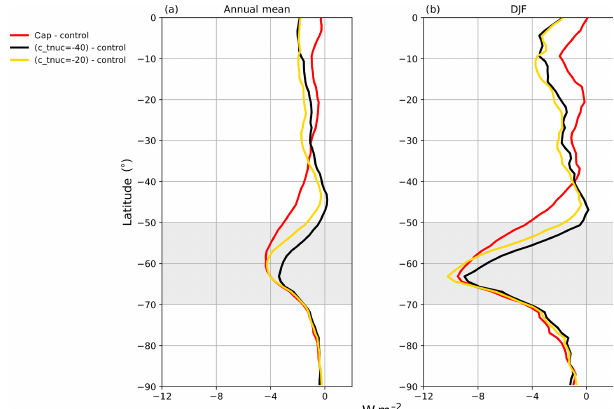
Figure 5. Distribution of zonally averaged SW CRE anomalies over the SH in various experiments with respect to the control model for (a) annual mean and (b) DJF mean. The colour codes are as follows: red indicates cap minus control, black indicates ( c_tnuc=-40 ) minus control; and yellow indicates ( c_tnuc=-20 ) minus control. Values are calculated from daily-mean output over 22 years. The SO region identified in this study is highlighted in